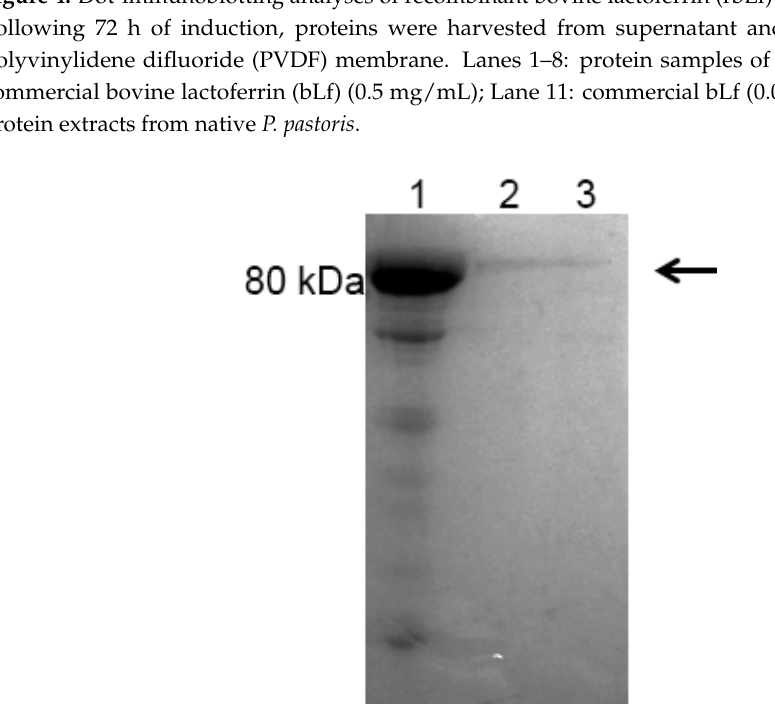
Figure 5. Sodium dodecyl sulfate polyacrylamide gel electrophoresis (SDS-PAGE) analyses of rbLf purified from the yeast culture. Lane 1: commercial bLf; Lanes 2–3: purified rbLf.